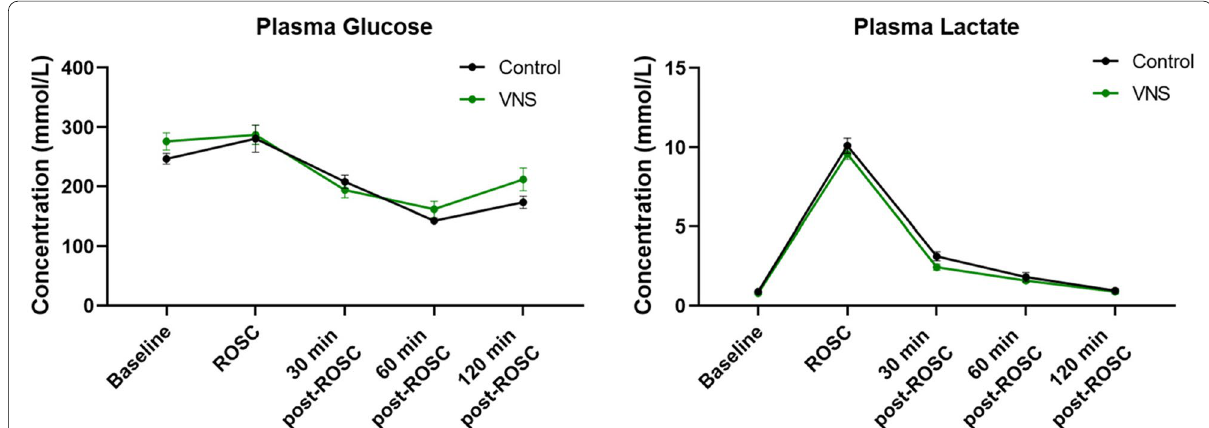
Fig. 4 Survival analysis and neurological deficit after CA with and without VNS. A significant survival benefit was observed after CA with the application of tVNS as compared with Control (87.5% v 37.5%, respectively; P < 0.05). Evaluation of mNDS at 24, 48, and 72 h post-CA showed a significant decrease in neurological scores in the control group as compared with the VNS group ( P < 0.05). N survival analysis and Student’s T-test was used for mNDS. tVNS